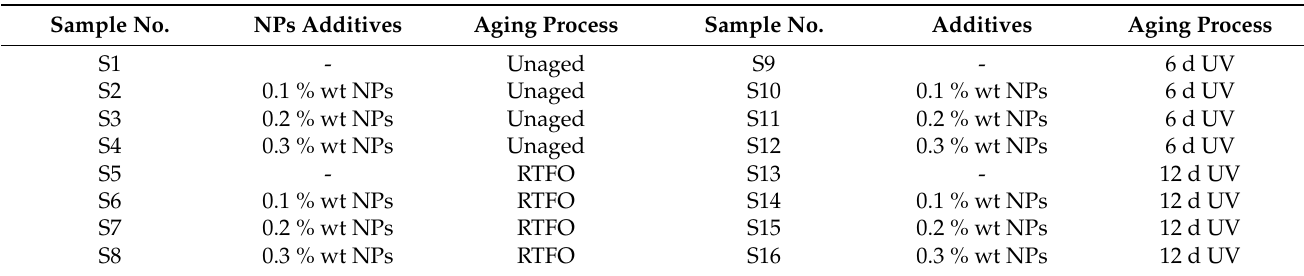
Table 3. Samples with different additives, and conditioning according to different aging processes (unaged, RTFO aged, and UV aged). Sample No. NPs Additives Aging Process Sample No. Additives Aging